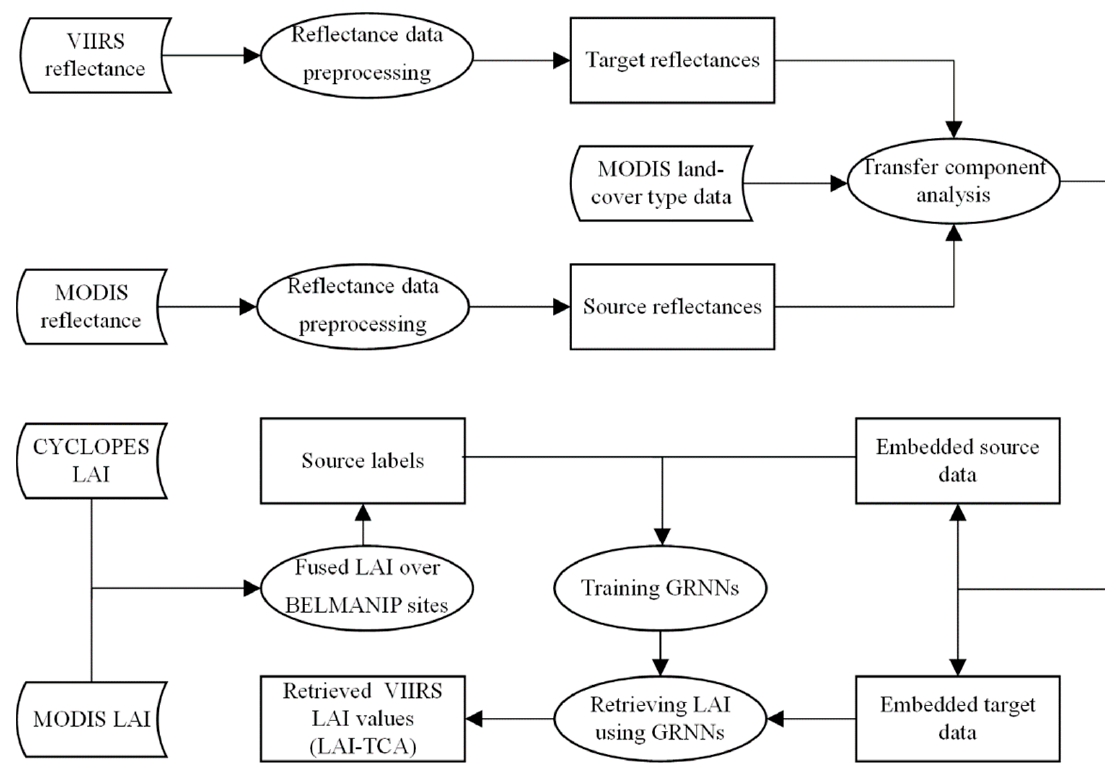
Figure 1. The LAI retrieval method based on domain adaptation.